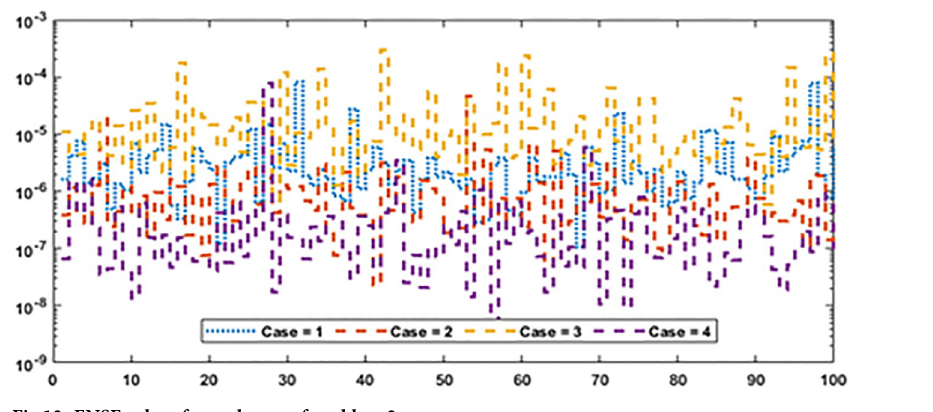
Fig 13. ENSE values for each case of problem 2.